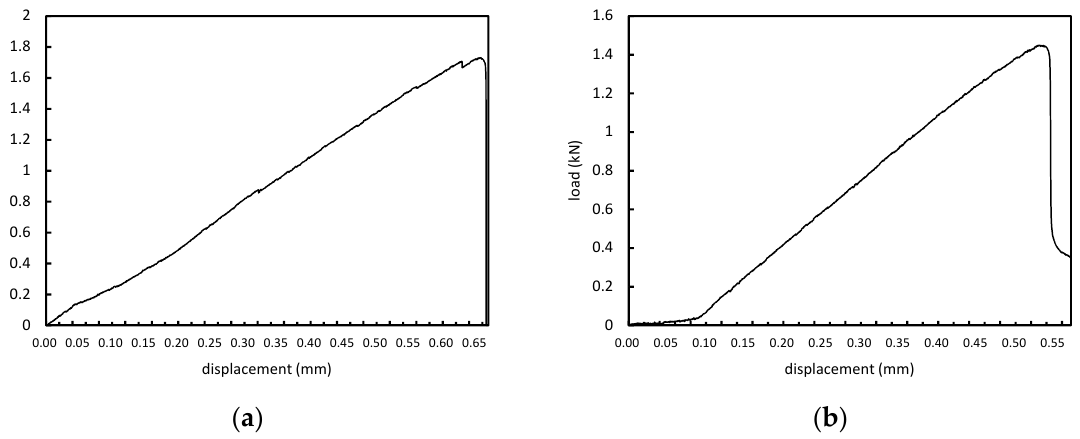
Figure 2. Load–displacement curves in the vertical direction: ( a ) (cid:1832) (cid:3051) = 1.21 kN ( b ) (cid:1832) (cid:3051) = 0.98 kN.